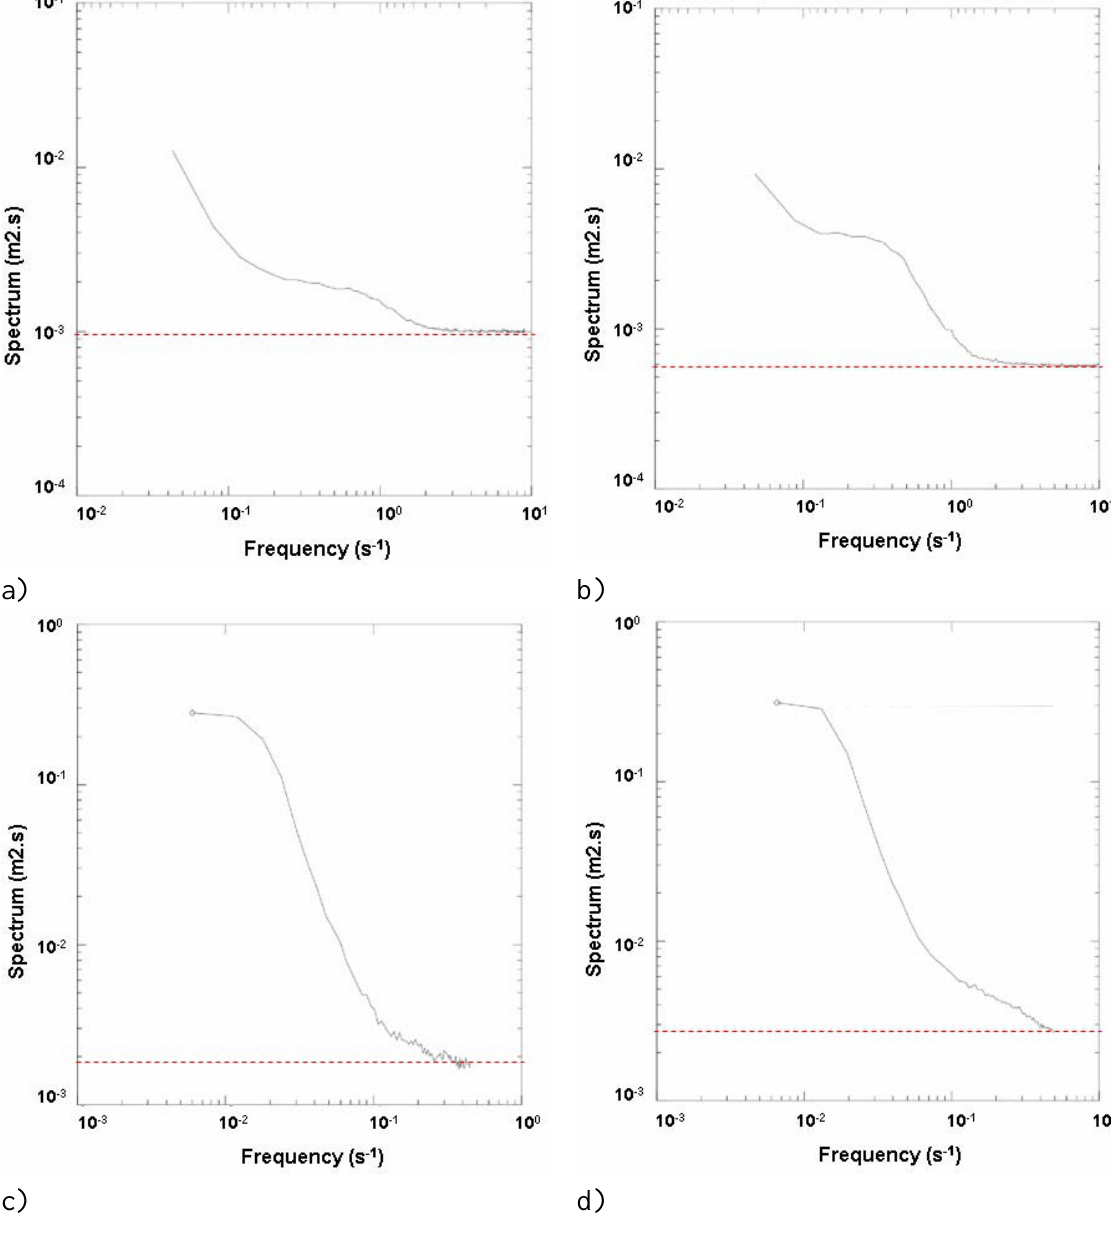
Figure 12. Power spectrum of (a) 20 Hz Envisat SSH, (b) 20 Hz Jason-1